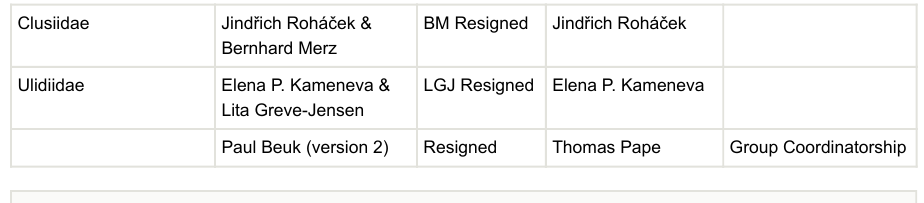
Table 3. Associated Specialists for Diptera–Brachycera and their